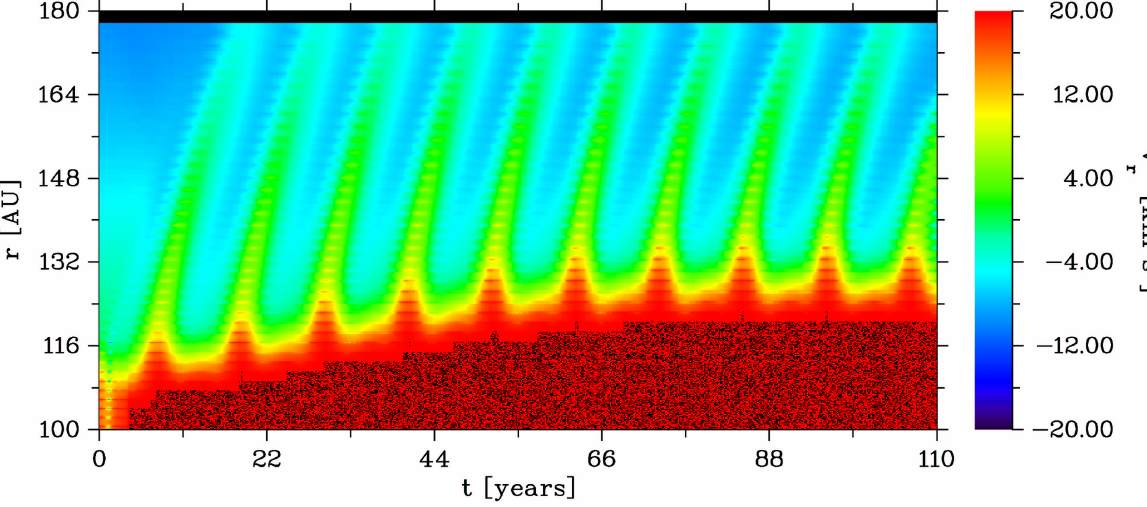
Fig. 7. The variation of the radial proton velocity in the sheath between termination shock and bow